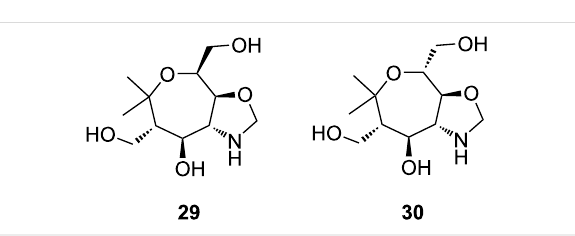
Figure 3: Proposed structures of the observed side products 29 and 30 during the hydrogenolyses of 14 and 15 .